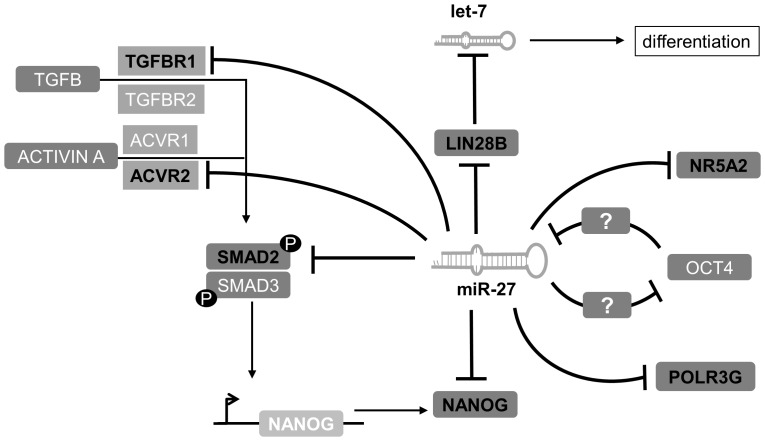
Schematic overview of our proposed regulatory network between miR-27 and pluripotency-associated genes.Genes highlighted in bold, black letters are those validated experimentally to be direct targets of miR-27.